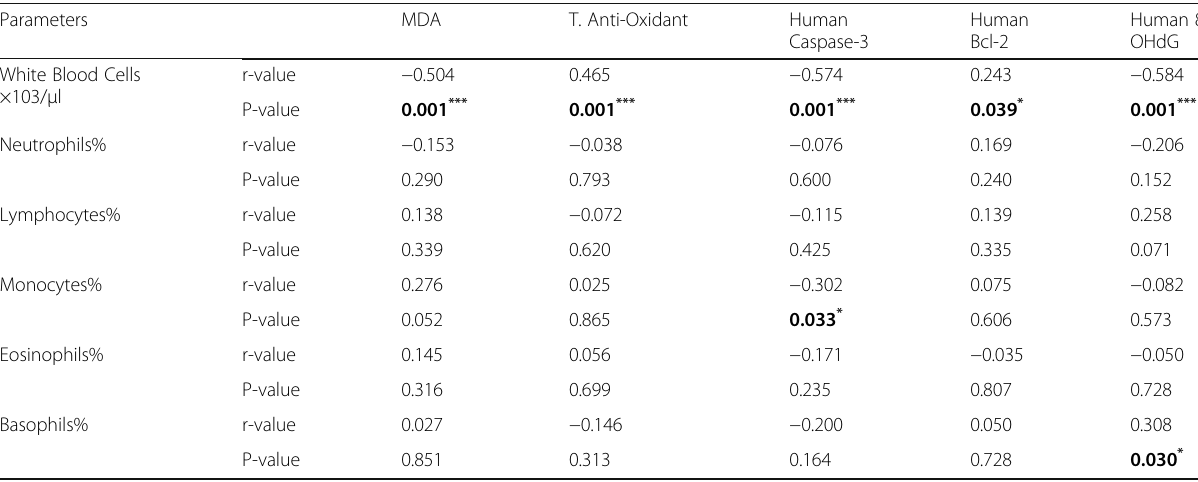
Human Human 8 Caspase-3 Bcl-2 OHdG